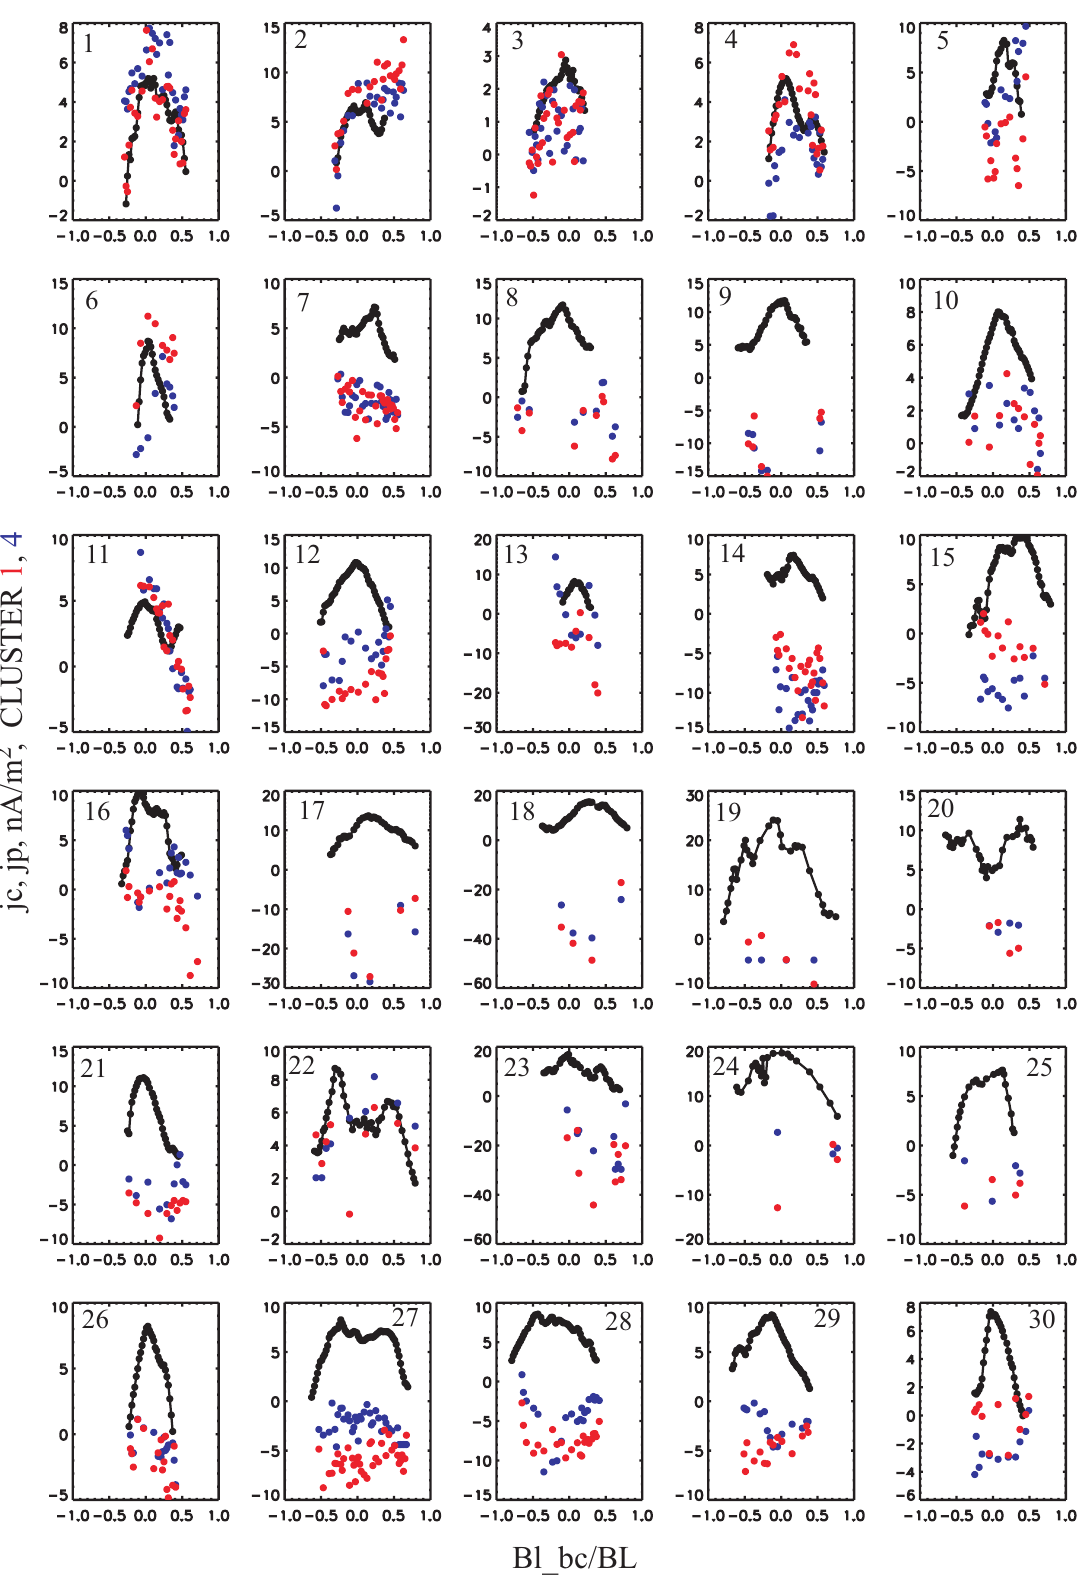
∼ N p V m at Cluster 1 (red) and 4 m